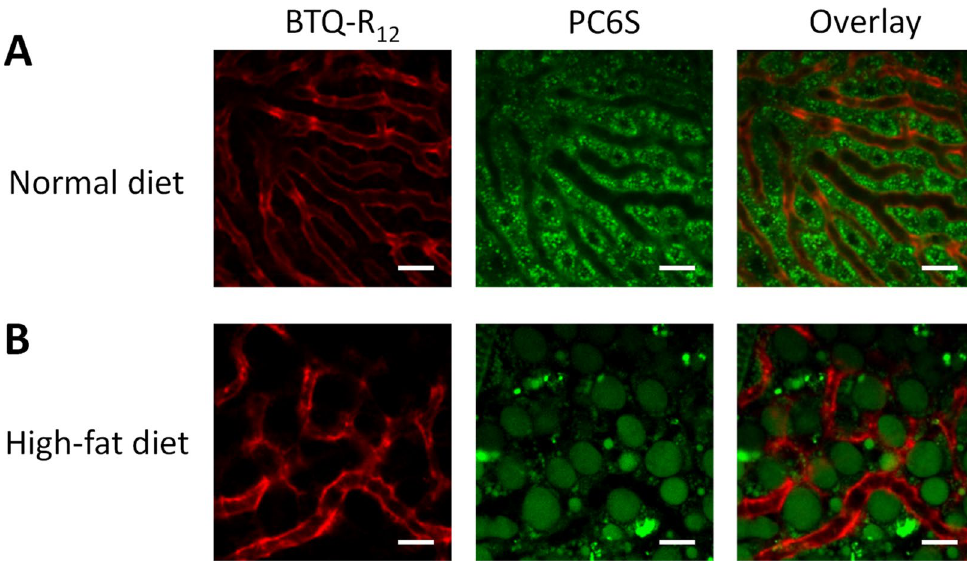
Figure 7. Phosphorescence and fluorescence intensity images of sinusoids (BTQ-R 12 , 100 nmol) and hepatic lipid droplets (PC6S, 50 nmol) in the liver of mice fed a normal diet ( A ) or high-fat diet ( B ) for 2 weeks. λ exc : 488 nm, λ em : > 620 nm (BTQ-R 12 ), 510–560 nm (PC6S). Scale bar: 50